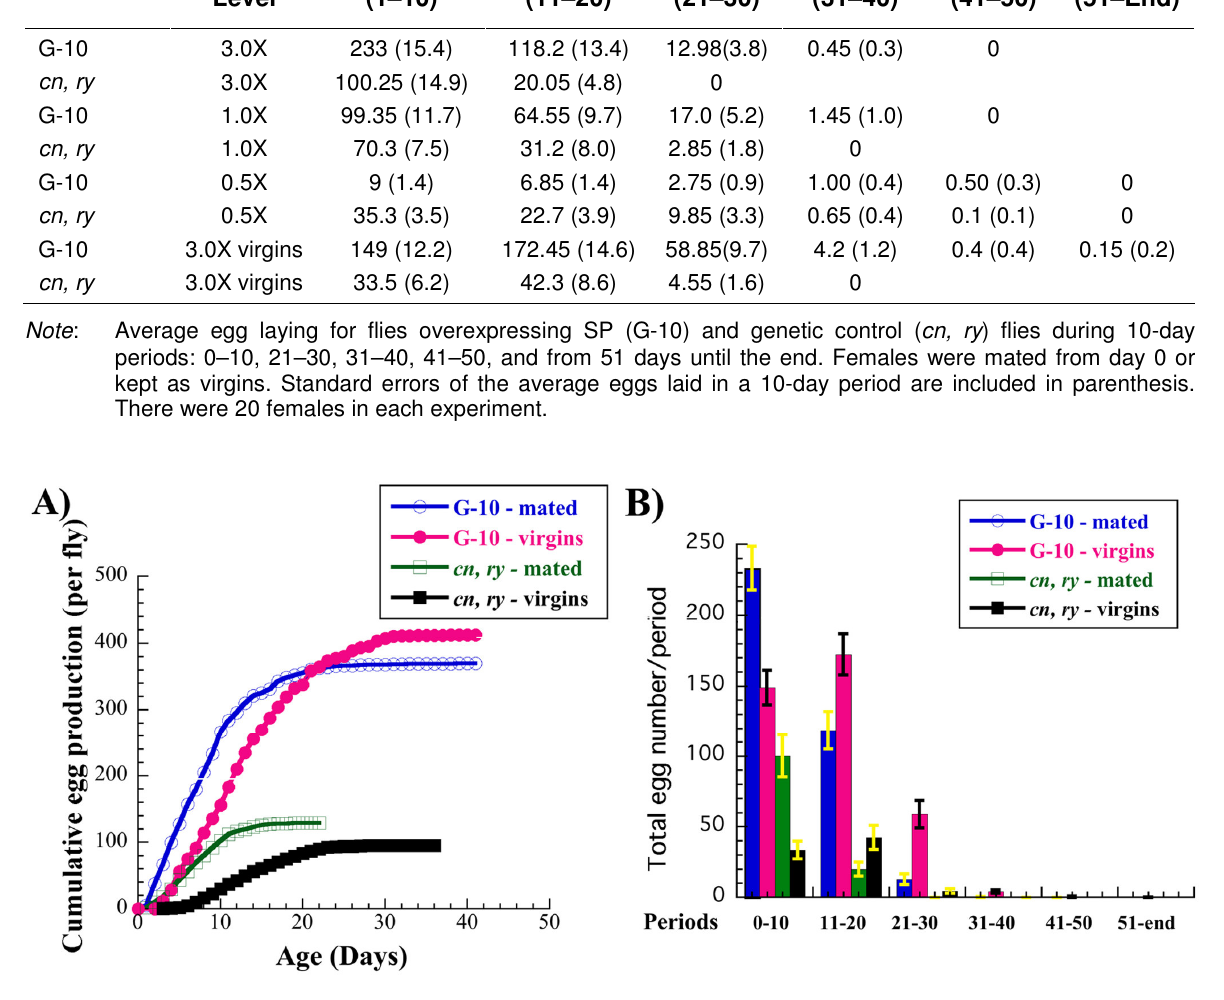
FIGURE 3. Mating increases early egg laying in G-10 flies overexpressing SP. (A) Cumulative lifelong egg production in G-10 flies overexpressing SP (blue and magenta)and genetic controls, cn, ry (green and black) mated from day 0 (blue and green) or kept as virgins (magenta and black). Female flies produced more eggs early when mated from day 0 compared to virgins, but the total number of eggs in mated G-10 is lower compared to the virgins. (B) Total egg number produced by G-10 (blue and magenta) and cn, ry (green and black) females kept as mated (blue and green) or virgins (magenta and black) in 10-day periods. Mated females produced more eggs during the first 0- to 10-day period, while virgin females laid the most eggs during the second period from 11 to 20 days. There were 20 females in each experiment.